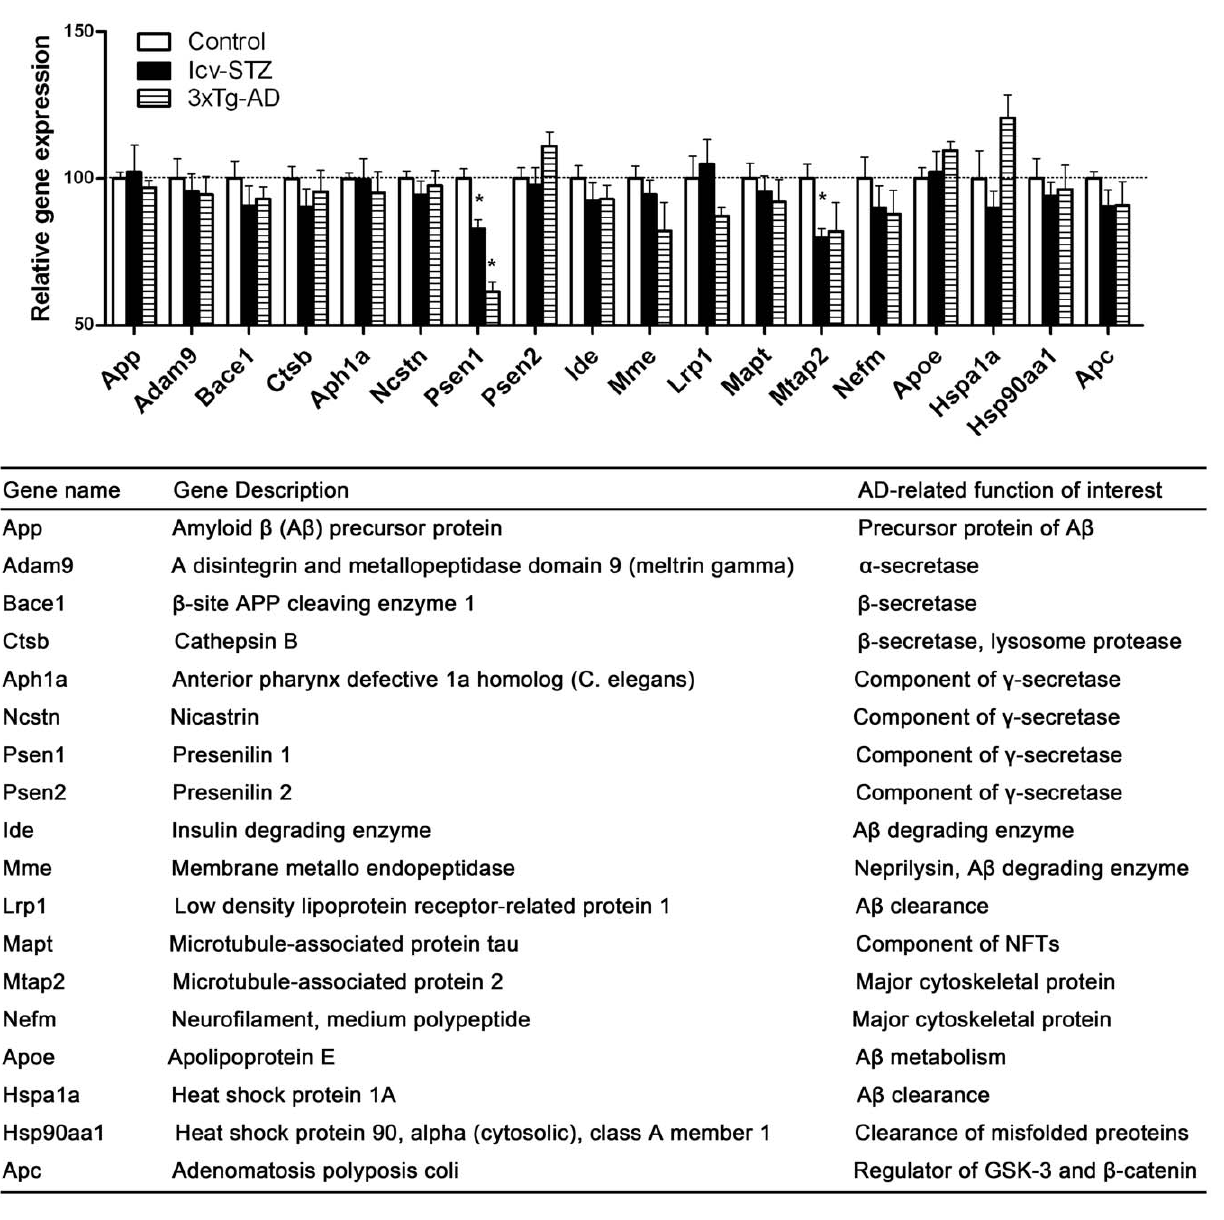
Figure 3. APP- and tau-related gene expressions.